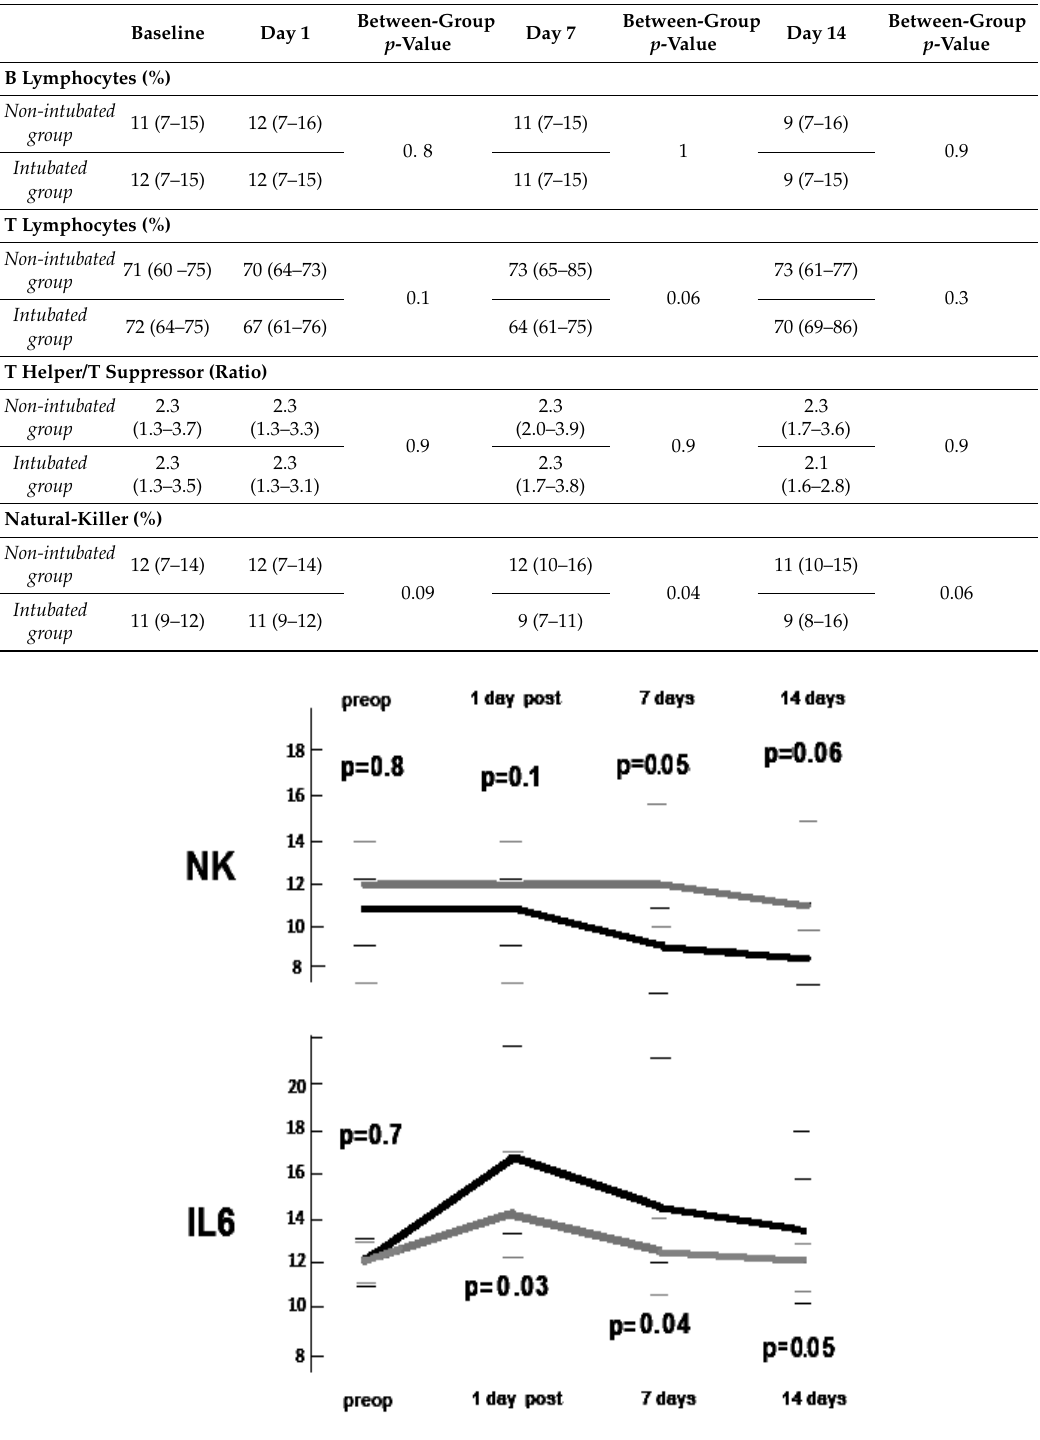
Figure 1. Median postoperative changes of natural killer (NK) lymphocytes and interleukin-6 (IL-6) for intubated (black line) and non-intubated (gray line) patients. Between group p -values at different intervals and interquartile ranges are indicated.